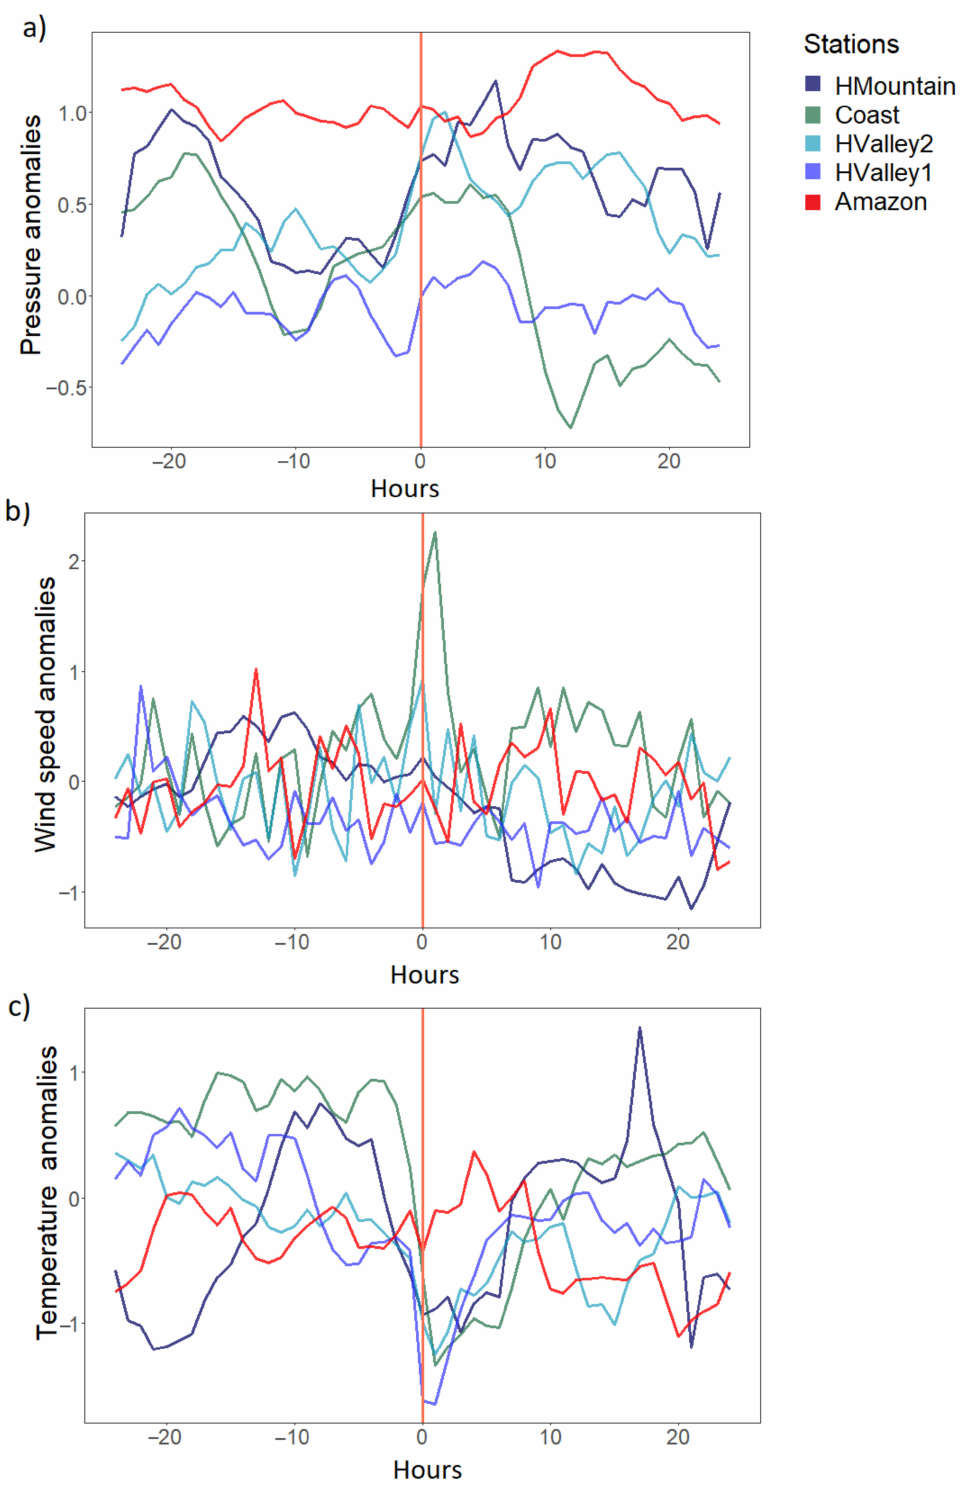
Figure 9. Average anomalies 24 h before and after each rainfall event of interest presented in Table 5: ( a ) atmospheric pressure ( b ) wind speed ( c ) temperature. The number of studied events per station are Coast (6), Andes Valley 1 (9), Andes Valley 2 (8), High Mountain (7), and Amazon